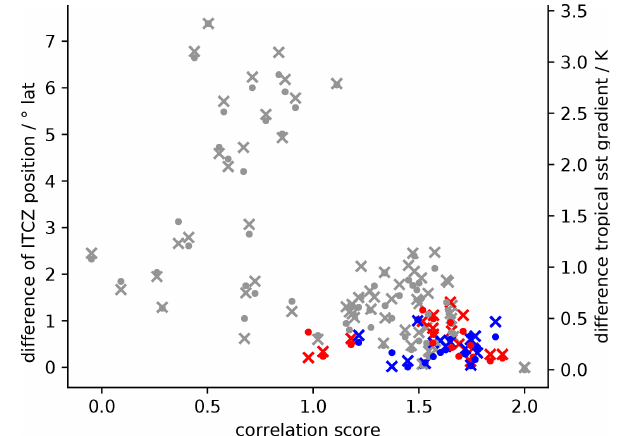
Figure 5. Pairwise inter-model correlation score versus the dif- ference in the ITCZ position and SST contrast of all model pairs. Model pairs with both models falling into the same multi-model cluster are colored in red (cluster 1) and blue (cluster2), respec- tively. The difference in the ITCZ position is marked by circles; the difference in the SST contrast is marked by